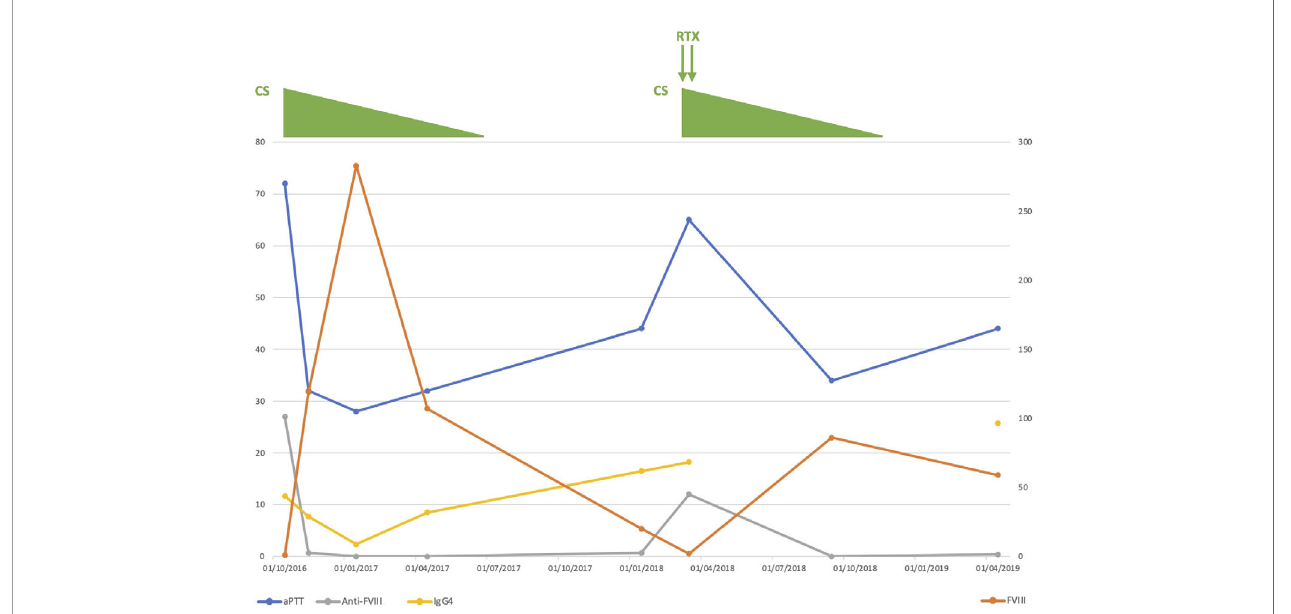
FIGURE 1 | Clinical course of our patient. Anti-FVIII, anti-FVIII activity; aPTT, activated partial thromboplastin time; CS, corticosteroids; FVIII, coagulation factor VIII; Ig, immunoglobulin; RTX, rituximab.